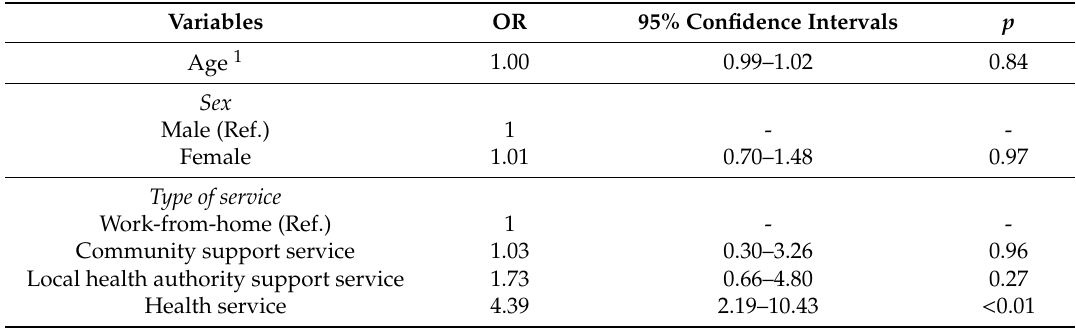
Table 2. Multiple logistic regression model with test result (positive vs. negative) as dependent